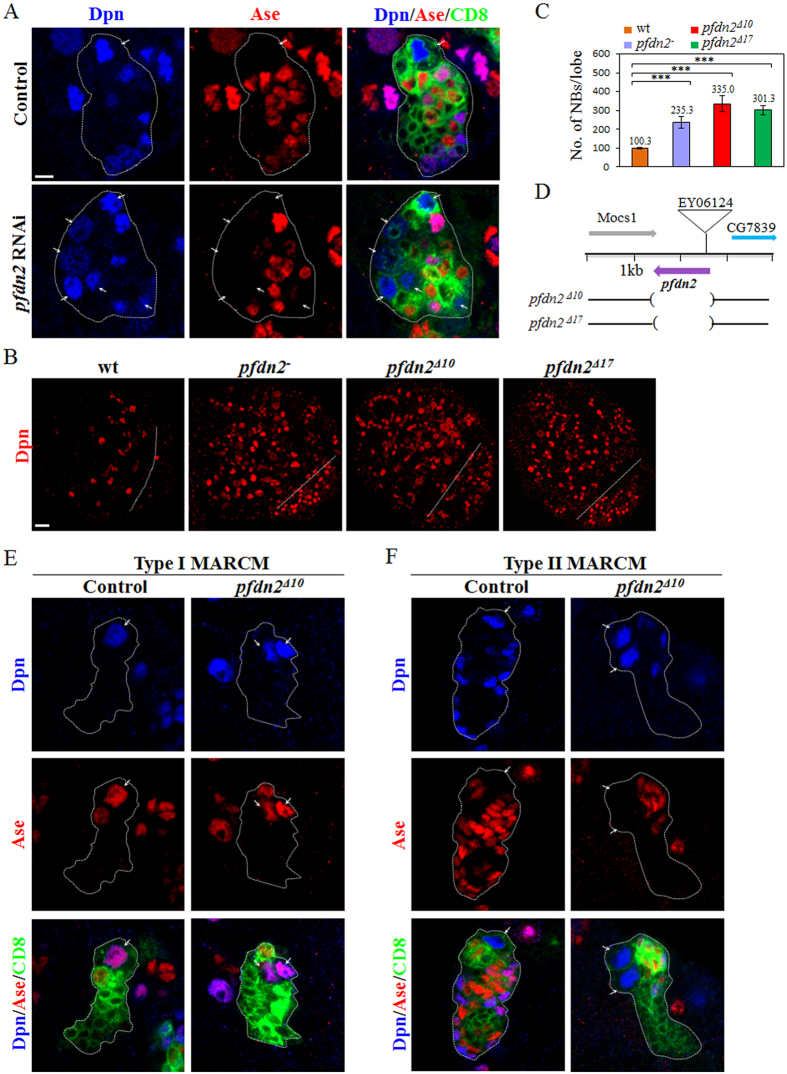
Pfdn2 suppresses neuroblast overproliferation in larval brains.(A) Type II driver control (wor-Gal4 ase-Gal80 UAS-CD8-GFP) and pfdn2 RNAi were labeled with Dpn, Ase and CD8. (B) Dpn was labeled in wild-type, pfdn2− [pfdn201239/Df(3L)BSC457], pfdn2Δ10, and pfdn2Δ17 larval brains. The central brain (CB) is to the left of the white dotted line, which markers the border between the CB and the optic lobe (OL). (C) Quantification of larval brain neuroblasts. ***indicates p < 0.001. Error bars indicate mean standard deviation. NBs, neuroblasts. (D) Schematic representation of pfdn2 genomic locus and the pfdn2 deletion alleles used for this study. The extent of the deletion is indicated by the parentheses. (E,F) MARCM driver control and pfdn2Δ10 MARCM clones were labeled with Dpn, Ase and CD8. Neuroblasts (Dpn+ Ase+ in type I lineages and Dpn+ Ase− in type II lineages) in the clones are indicated by arrows. Individual neuroblast clones or lineages are marked by CD8::GFP and outlined by white dotted lines. Scale bars: 5 μm (A,E–F), 20 μm (B).